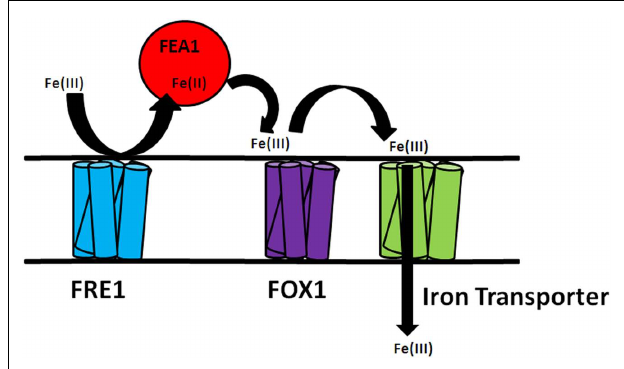
FIGURE 1 | Hypothetical model of FEA1 iron assimilation in Chlamydomonas reinhardtii. Available ferric iron is reduced to ferrous iron by reductases (FRE1). FEA1 protein binds ferrous iron and facilitates uptake by iron